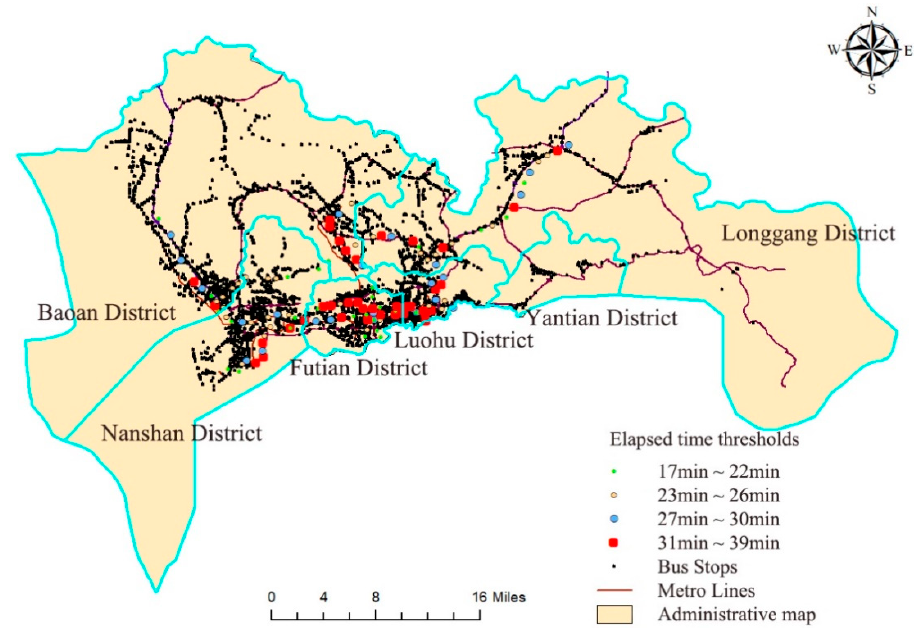
Figure 10. Spatial configuration of metro-to-bus elapsed time threshold during weekday morning peak hours in Shenzhen.